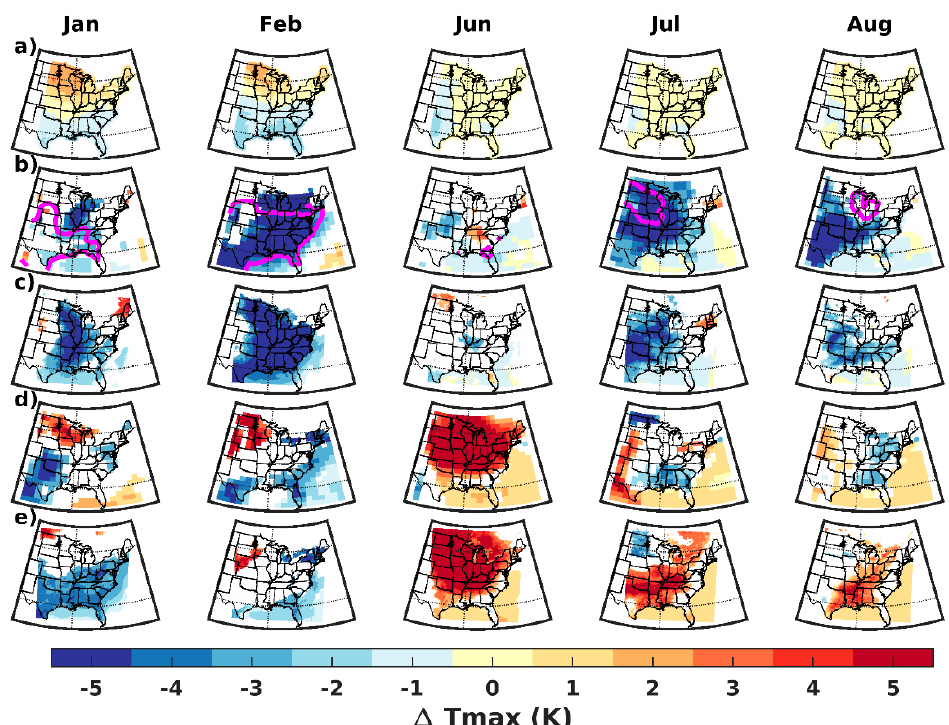
Figure 3. Monthly mean maximum 2-m temperature anomalies (Tmax, in Kelvin) differenced by ENSO phase (strong El Niño - weak La Niña) for the ( a ) NOAA ENSO Climate Normals dataset [10], ( b ) HadGEM2 output for the two historical years simulated using HadGEM2-WRF, ( c ) HadGEM2-WRF historical climate simulations at 4-km domain resolution, ( d ) HadGEM2 output for the two matching WRF future simulated years, and ( e ) HadGEM2-WRF future climate simulations. Differences in ( b – e ) are only shown for grid cells for which a two-sample t test indicates they are significant at a 95 % confidence interval. The magenta lines in ( b ) show the area covered by a mean Tmax difference of − 0.5 °C for all strong El Niño - weak La Niña events in the historical climate, as simulated by HadGEM2.